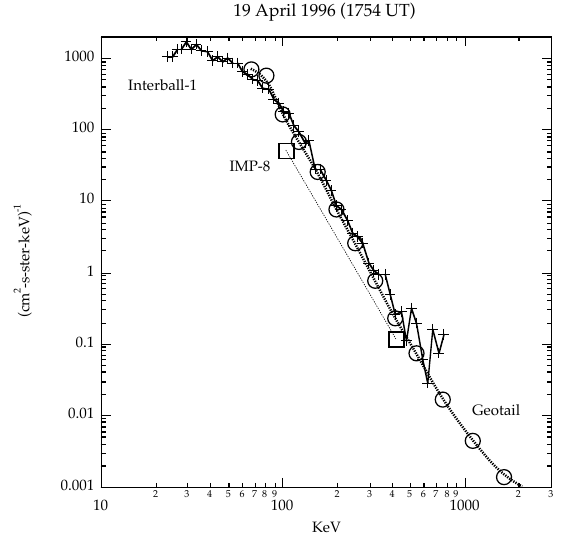
Figure 6. A comparison of Geotail (circles), Interball-1 (crosses0, and Fig. 6. A comparison of Geotail (circles), Interball-1 (crosses, and IMP-8 (squares) energetic ion spectra near 1754 UT on April 19, IMP-8 (squares) energetic ion spectra near 17:54 UT on 19 April 1996. The spectra were selected when the flux peaked: 1753:17 UT 1996. The spectra were selected when the flux peaked: 17:53:17 UT on Geotail, 1756:39 UT at Interball, and 1753:55 UT at IMP-8. on Geotail, 17:56:39 UT at Interball, and 17:53:55 UT at IMP-8.